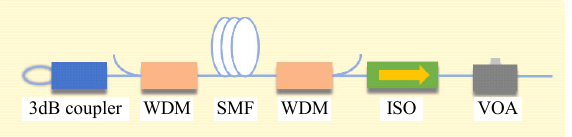
Fig. 2 Configuration of RFL. WDM: wavelength division multiplexer; SMF: single mode fiber; ISO: isolator; VOA: variable optical